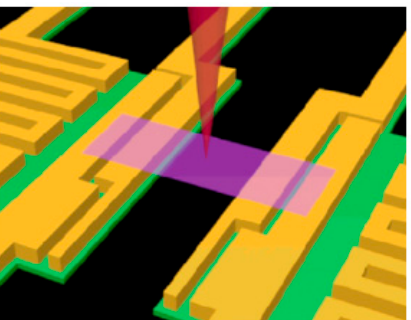
Figure 6. Electron beam self-heating method [104]. Reprinted with permission from ref. [104]. Elsevier and Copyright Clearance Center.